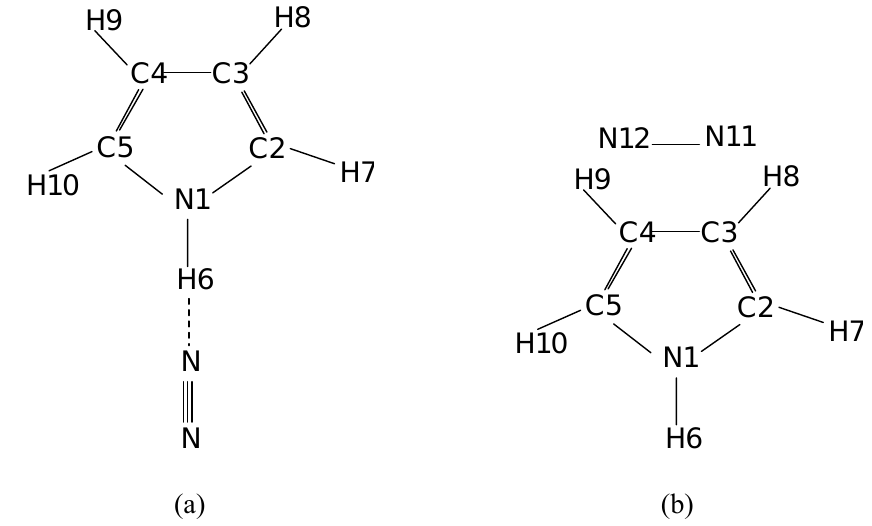
Figure 1 . Isomers of pyrrole…nitrogen complex (a) hydrogen bonded, (b) T – shaped